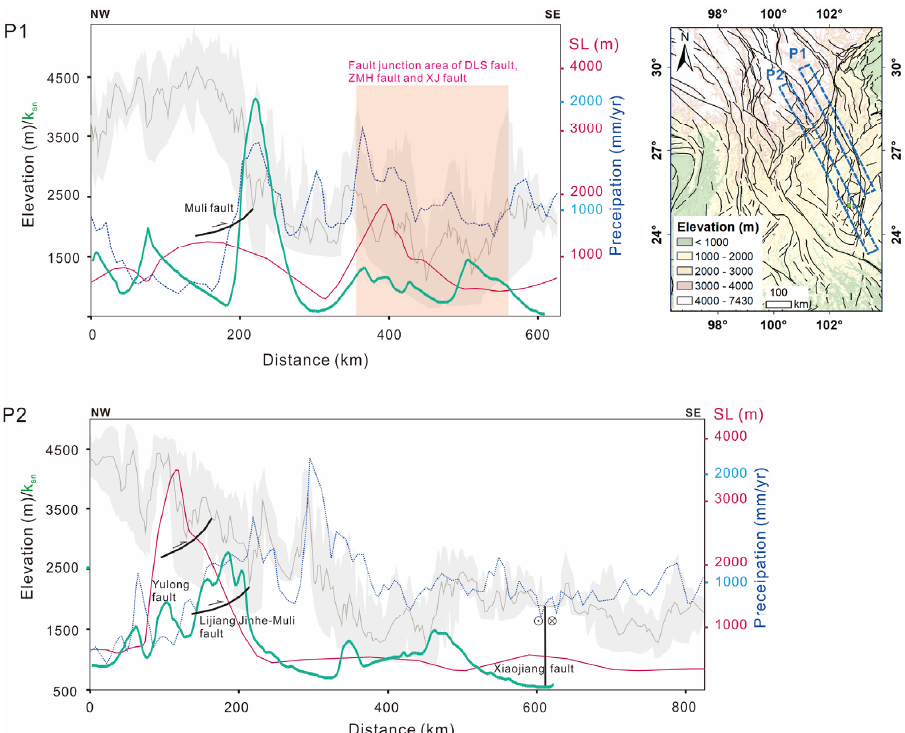
Figure 12. Swath profiles of topography, SL, and precipitation, averaged over a 20-km width of each profile. The grey area marks the boundaries of maximum and minimum elevation. The grey line represents the mean elevation. The red line represents SL values, the green line represents the K sn values, and the blue dots are mean annual precipitation (1997–2006). The locations of the swath profiles are marked as blue dashed rectangle in the inset map.